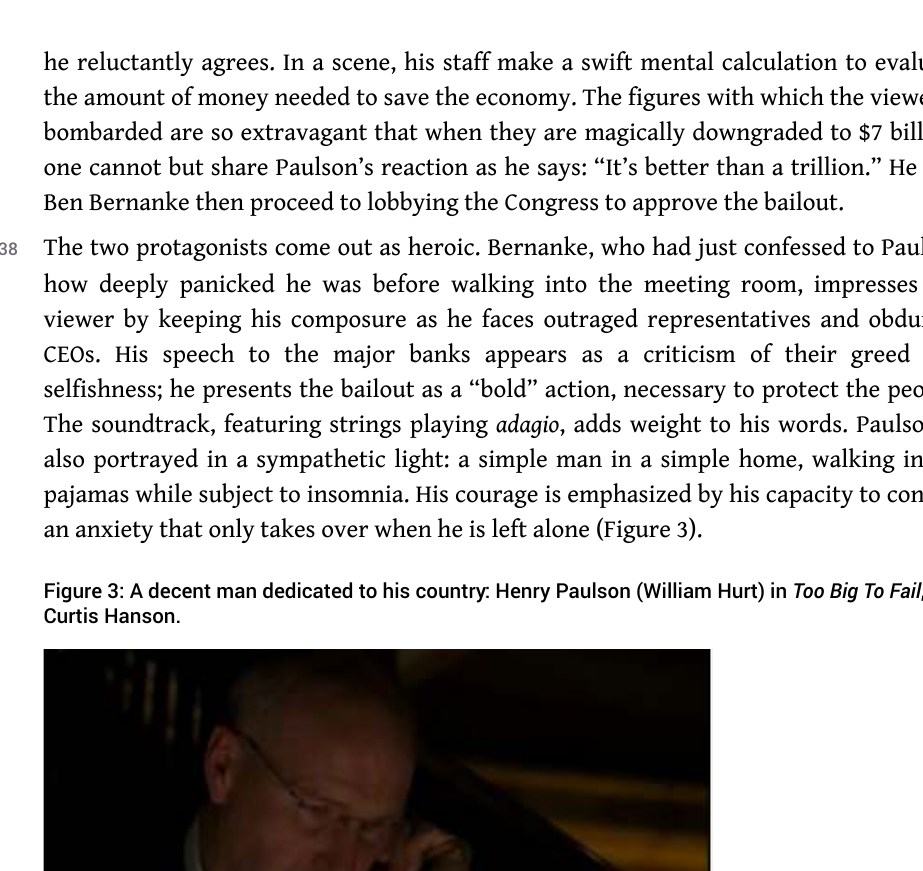
Source: Too Big To Fail, by Curtis Hanson (screen